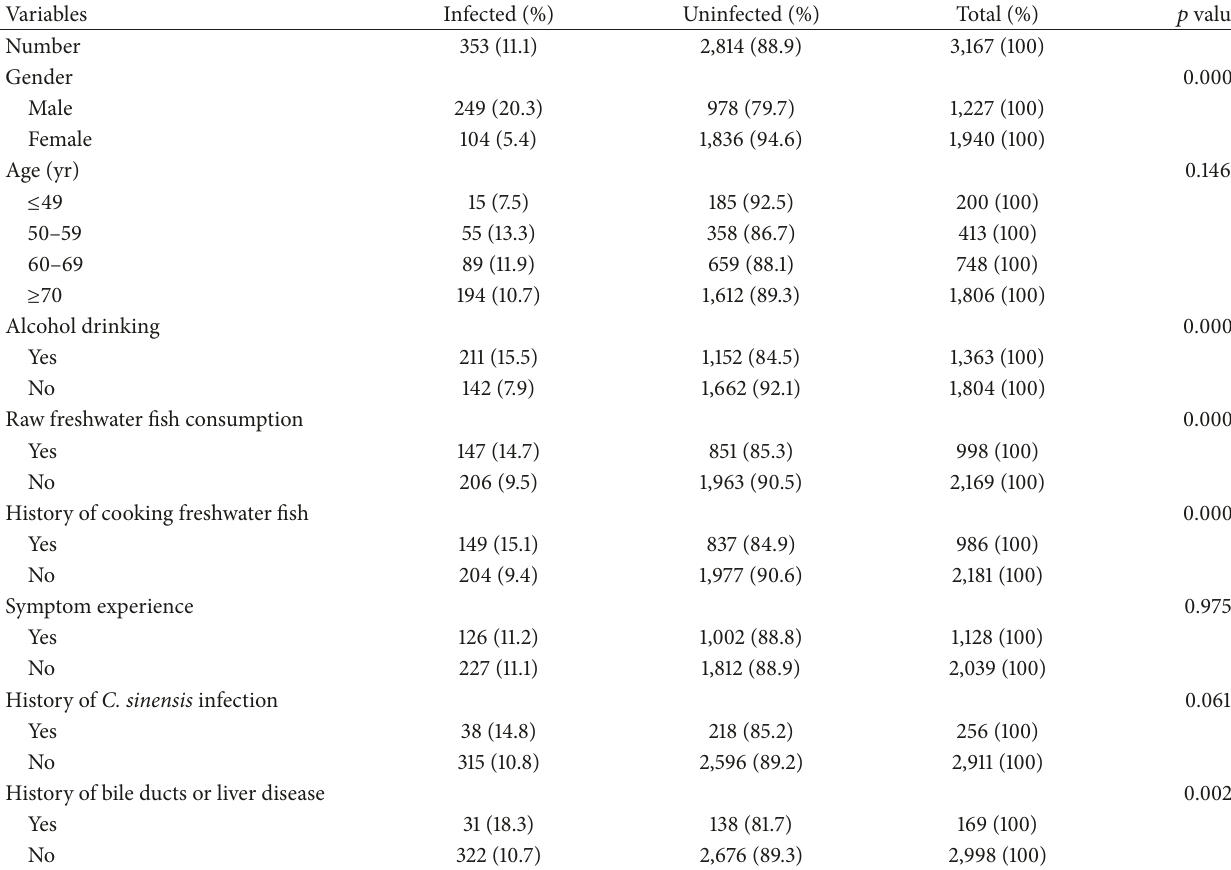
Table 3: C. sinensis infection rates based on sociodemographic and behavioral